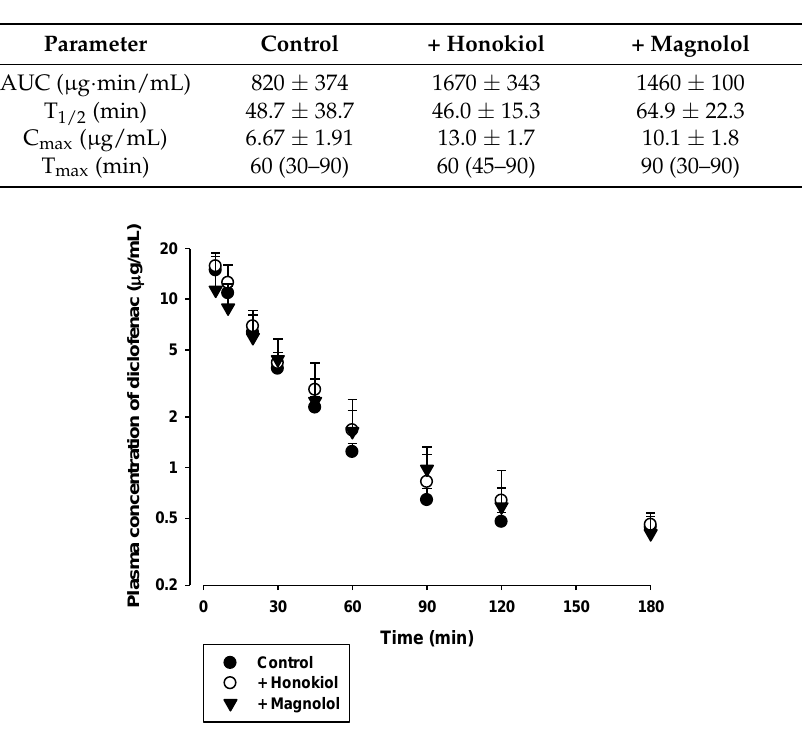
Figure 3. Plasma concentration versus time profiles of phenacetin in rats following its oral administration at a dose of 20 mg/kg without (●) or with 5 mg/kg intravenous honokiol ( ○ ) or magnolol ( ▼ ). The bullet symbols and their error bars represent the means and standard deviations, respectively ( n = 4‒5). Table 1. Pharmacokinetic parameters of phenacetin in rats following its oral administration at a dose of 20 mg/kg with or without 5 mg/kg intravenous honokiol or magnolol ( n = 4‒5).